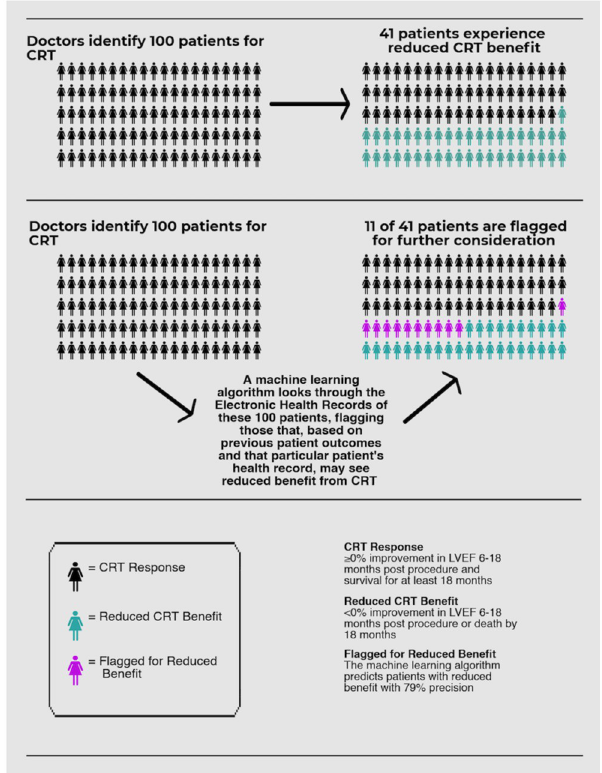
Fig 3. Illustration of envisioned clinical utilization of machine learning